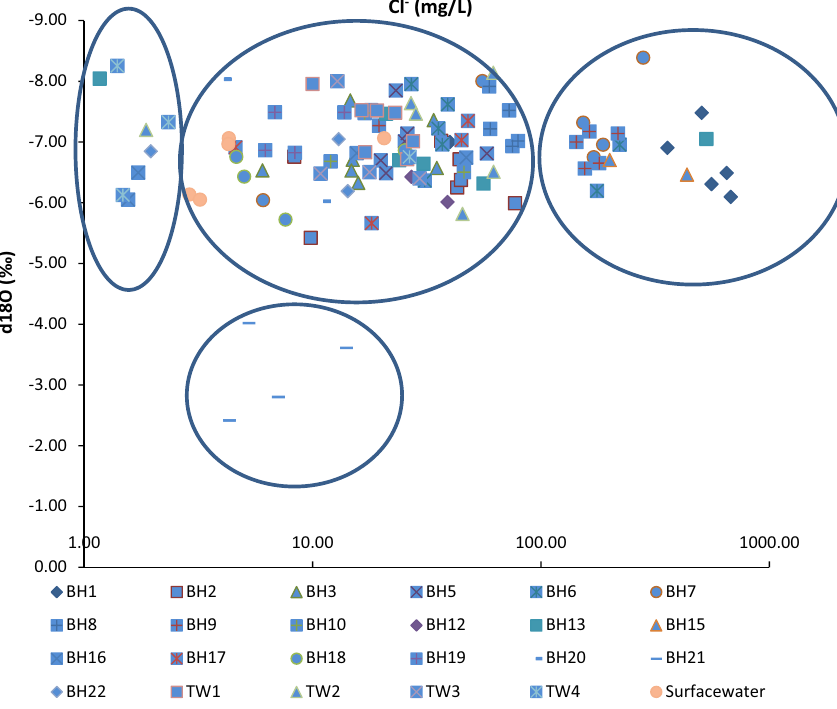
Fig. 3 Chloride versus δ 18 O concentration for river water and groundwater in the Lower Muda River